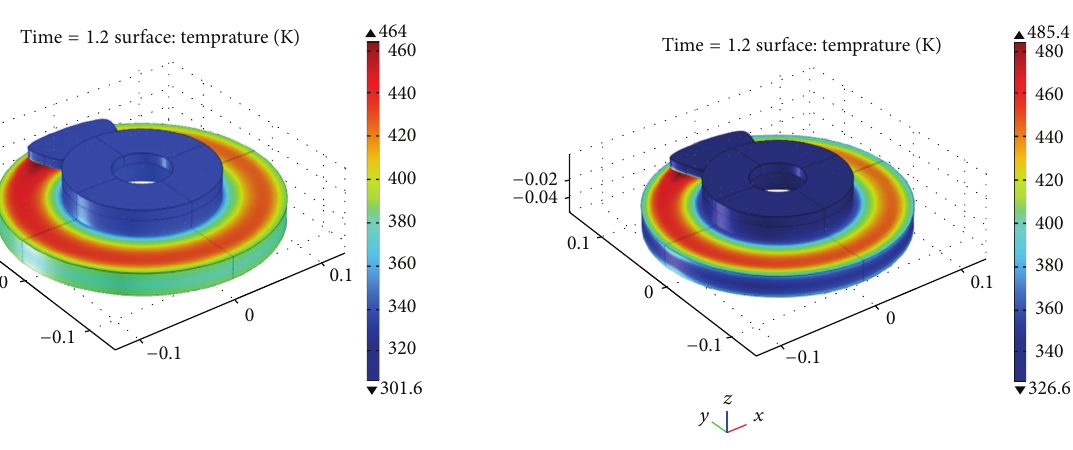
Figure 4: Temperature distribution for GCI disc and asbestos pad at 𝑡 = 1.2 seconds.